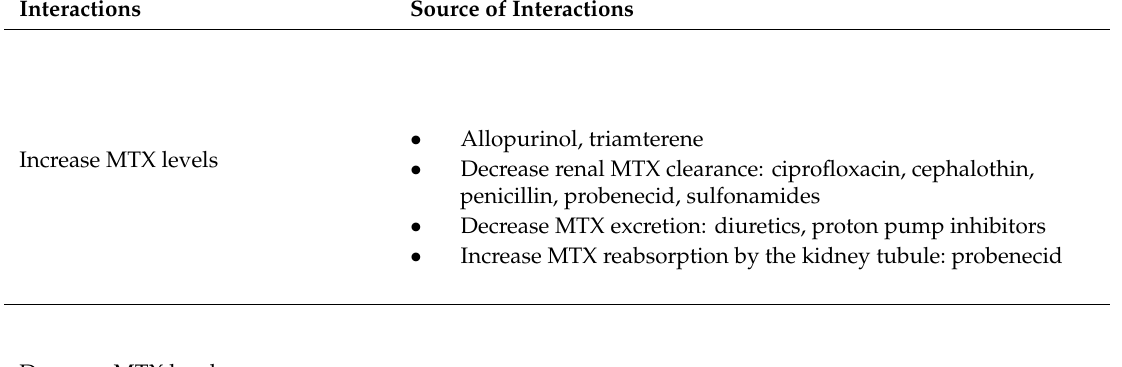
Table 1. Drug interactions. MTX,